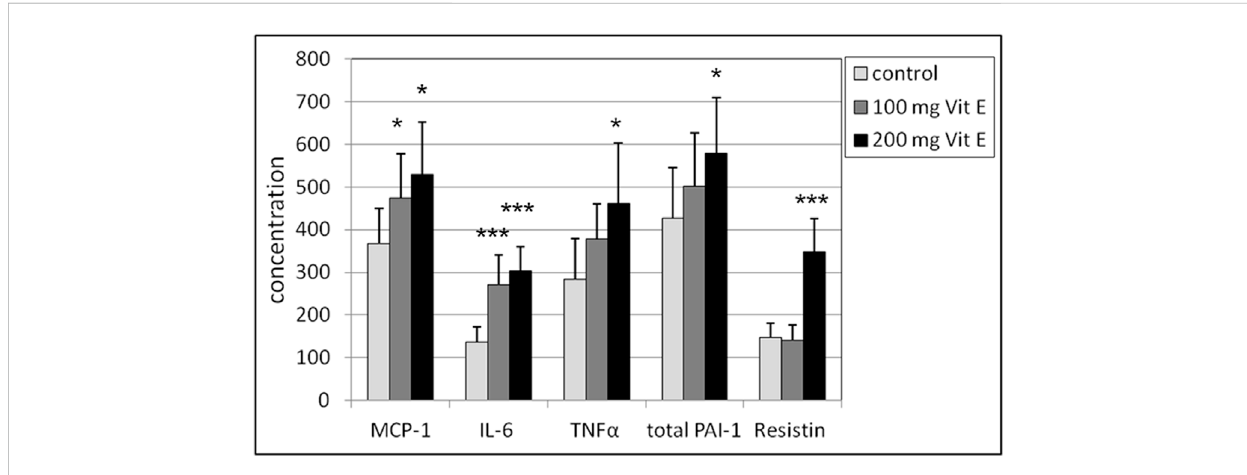
FIGURE 5 Renal supernatant concentrations in male mice of MCP-1, IL-6, TNF- α , resistin (expressed in pg/mL) and PAI-1 (expressed in μ g/mL). Statistics: * p < 0.05 vs. control group; *** p < 0.001 vs. control group. Reprinted from Jansen et al.